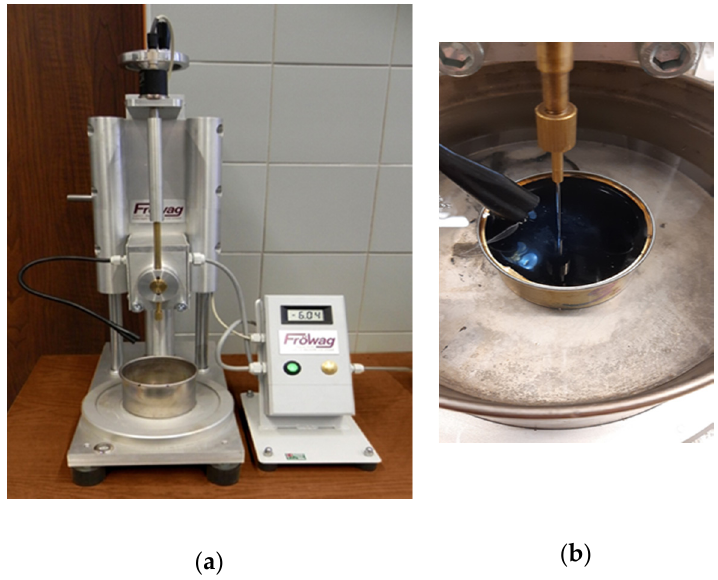
Figure 3. Automatic penetrometer for bitumen testing ( a ), bitumen specimen during testing ( b ) (photo by M. M. Iwa ń ski).